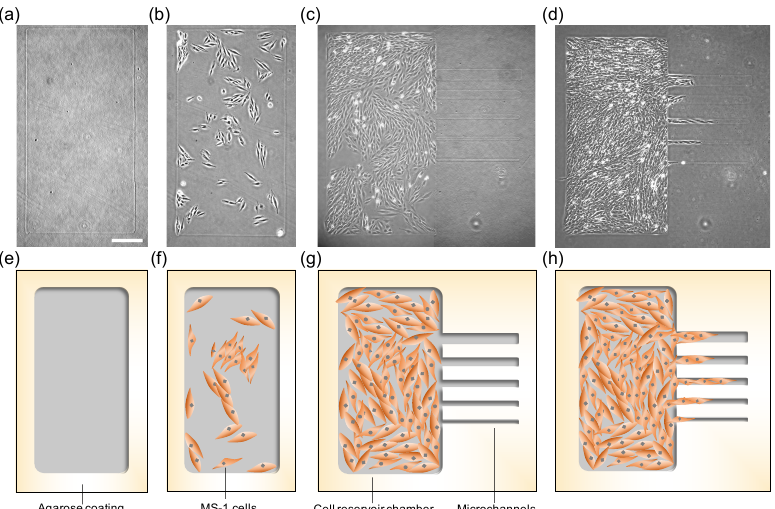
Figure 2. Application of agarose microfabrication technology for assessing collective cell dynamics in microchannels. ( a – d ) Micrographs of the stepwise microfabrication of channels for collective cell migration analysis. To display the whole image of the reservoir chamber and the microchannels as a micrograph, two micrographs (the left half of the chamber image and the right half of the chamber image) were taken and combined. ( e – h ) Schematics of Figures ( a – d ), respectively. ( a , e ) Agarose reservoir chamber was fabricated by melting a part of the agarose coating. ( b , f ) MS-1 cells were applied into the culture dish and adhered to the reservoir. ( c , g ) After MS-1 became nearly confluent, microchannels were formed in the agarose coating. ( d , h ) Cells were expanded into the microchannels. Bar: 300µm.